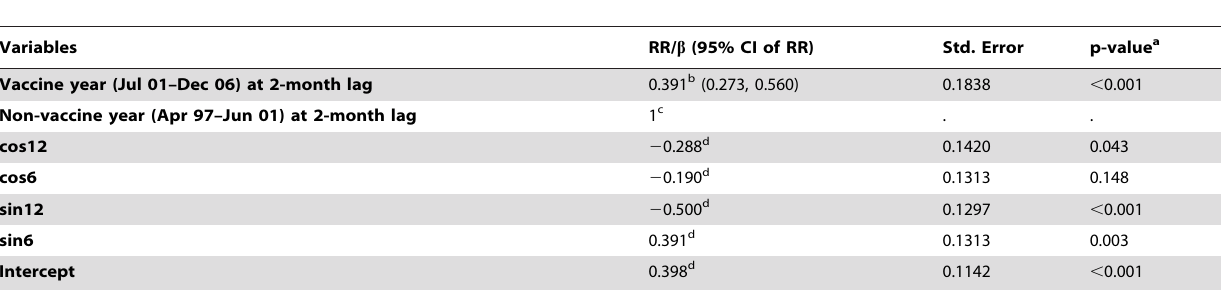
Table 1. Multivariable estimate of JE risk ratio for vaccine coverage year, controlling for seasonal periodicity using Poisson